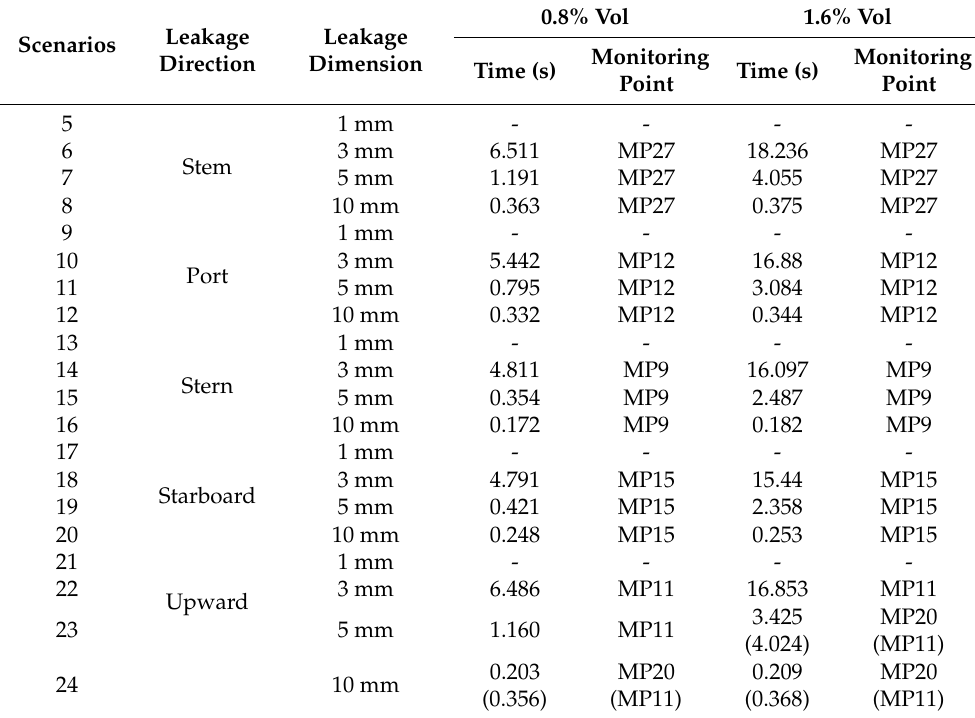
Table 7. Time points and corresponding monitoring points when the hydrogen concentration first reached 0.8% and 1.6% in scenarios